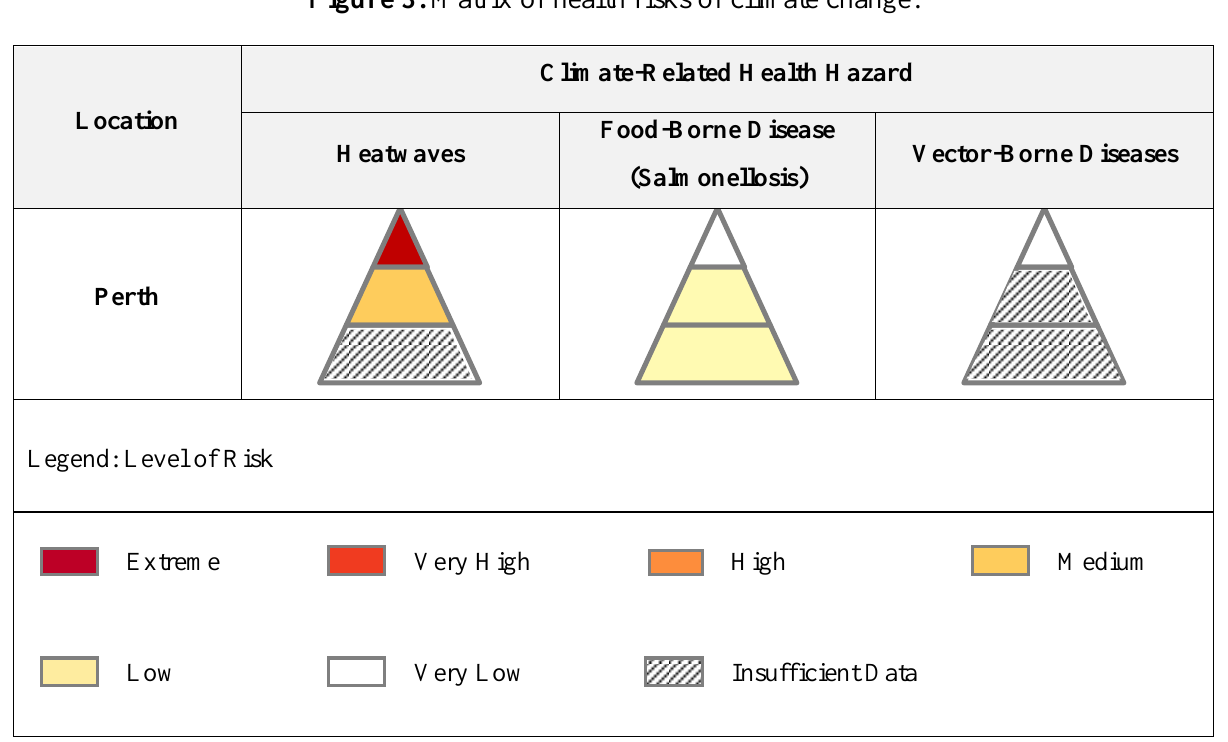
Figure 3. Matrix of health risks of climate